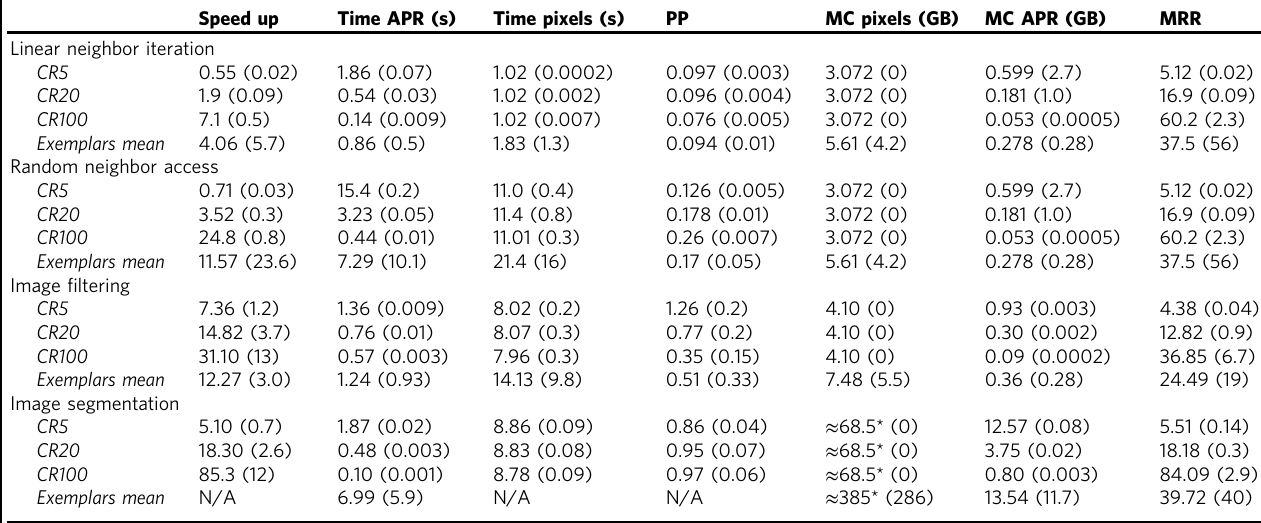
Table 2 Processing benchmarks on synthetic and exemplar images Speed up Time APR (s) Time pixels (s) PP MRR Linear neighbor iteration